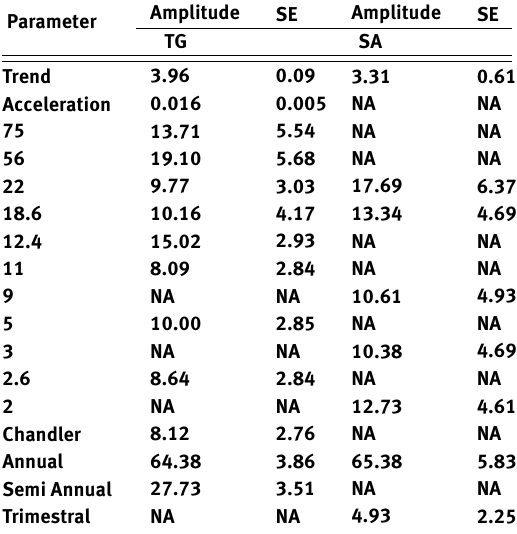
Table 1. Statistically significant (95 % CL) SA and TG solution pa- rameters. Trend and acceleration estimates and their 1 σ standard errors (SE) are in mm/yr and mm/yr 2 . The amplitudes of the period- icities (yr) and their SE are in mm. NA: Not Available.